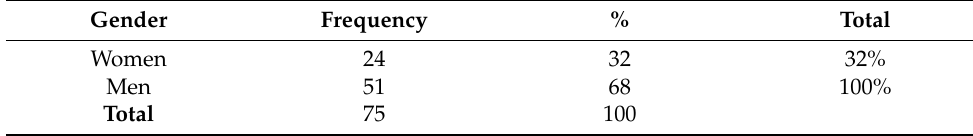
Table 4. Cumulative gender frequency.